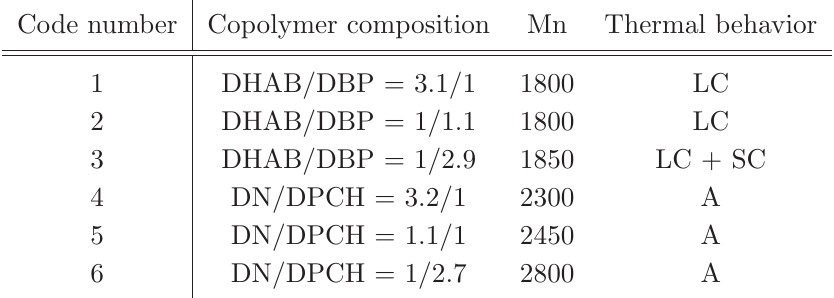
Table 1 Characteristics of the investigated